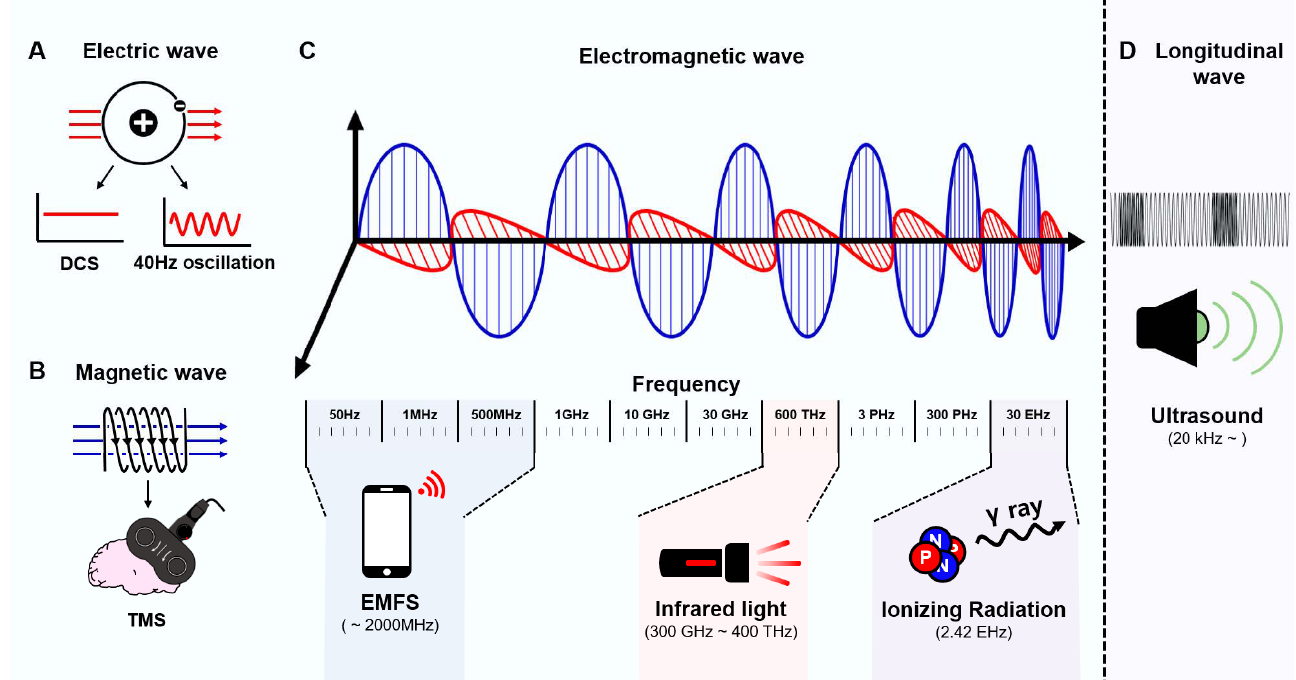
Figure 1. Brief overview of power source of electroceuticals used for the treatment for AD. ( A ) An electric wave is divided into direct current and alternative current, which are used for DCS and 40-Hz oscillation, respectively. ( B ) Magnetic field-induced wave used for the stimulation of TMS. ( C ) Perpendicularly crossed waves of magnetic and electric waves are referred to as electromagnetic fields, which are used for EMFS (~2000 MHz), stimulation of infrared light (300 GHz–400 THz), and stimulation of ionizing radiation (2.42 EHz). ( D ) Ultrasound is a longitudinal waveform used for the stimulation of focused ultrasound, which requires a medium for transferring the